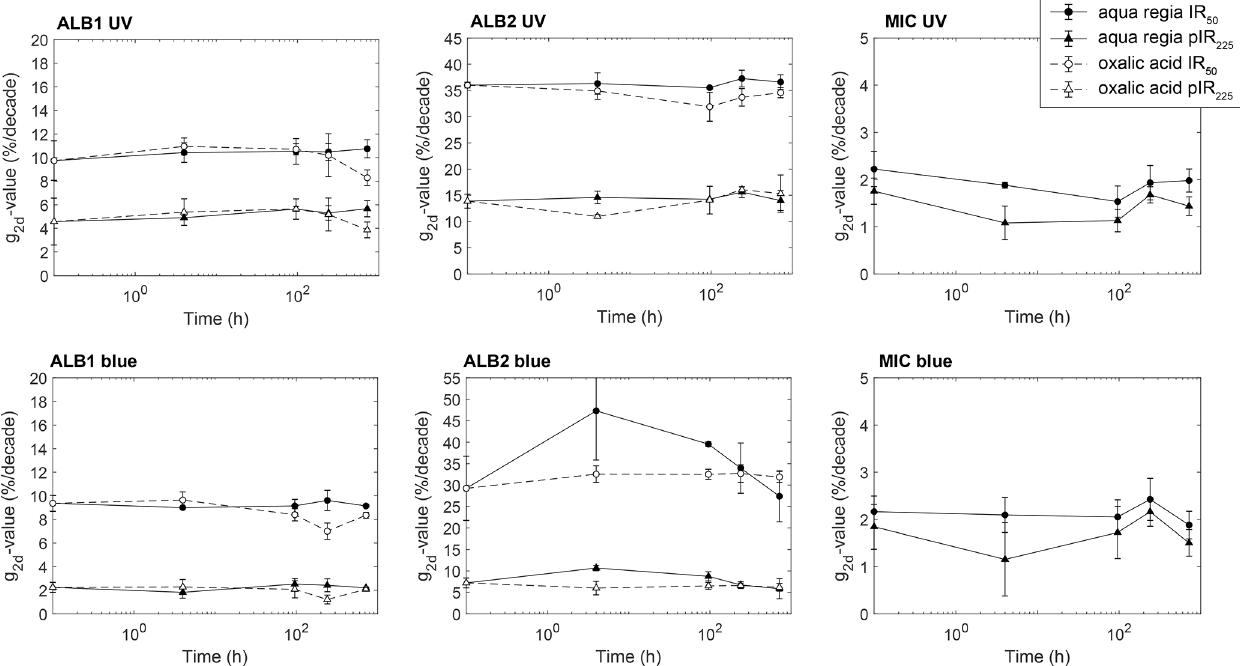
Figure 7. Multi-grain fading data of the IR 50 (circle) and pIR 225 (triangle) signals treated with aqua regia (filled) and oxalic acid (unfilled).